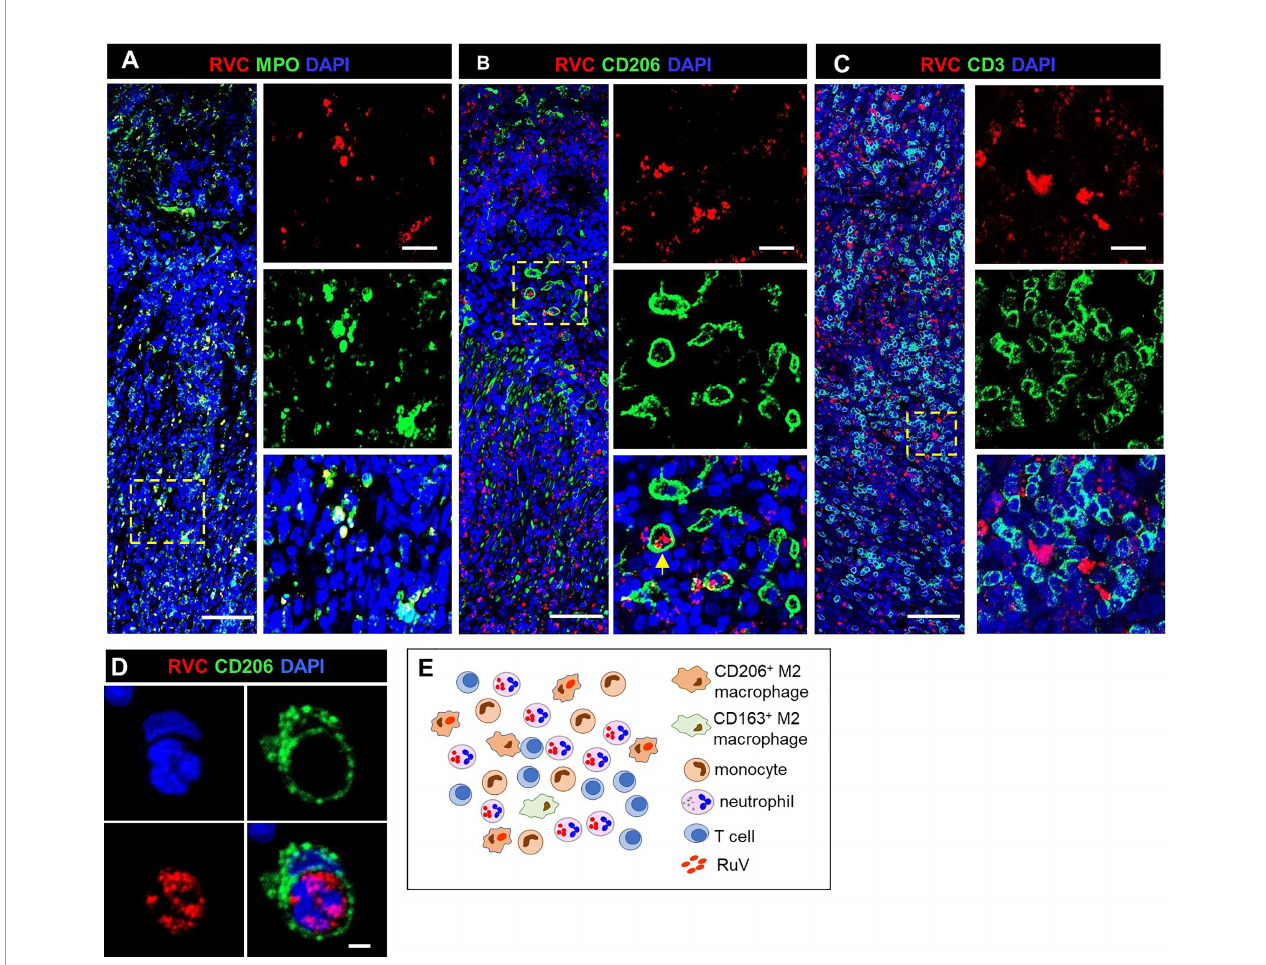
FIGURE 6 | A structure of DNI-type RuV-associated granuloma and its cellular elements. Histological double immuno fl uorescent staining for RVC and either MPO (A) , CD206 (B, D) , or CD3 (C) showing RVC + MPO + neutrophils, RVC + CD206 + macrophages with globular RVC likely in a phagosome (yellow arrow) and abundant RVC - CD3 + T cells in the in fl amed GI tissue of P16 (A – C) . RVC + neutrophil phagocytized by CD206 + macrophage (D) . Scale bars: 100 µm (A-C) , 20 µm (inlets), and 2 µm (D) . Schematic of DNI-type RuV- associated granuloma pattern (E)